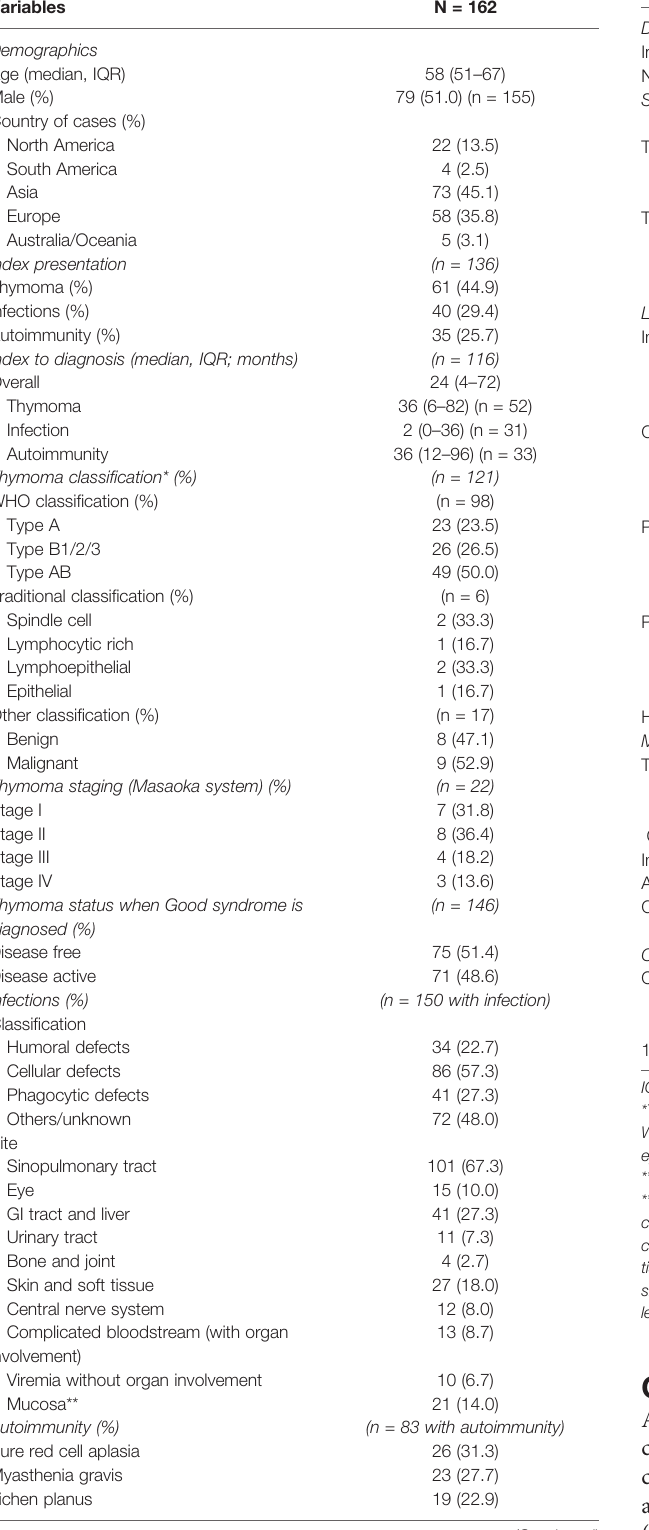
A total of 25 patients (15.4%) died at the time of report. The main cause of mortality was infection (n = 23, 92.0%). In the whole cohort, factors impacting mortality consistently in both univariate and multivariate logistic regression included thymoma status (active disease, odds ratio [OR] 4.157, 95% con fi dence interval